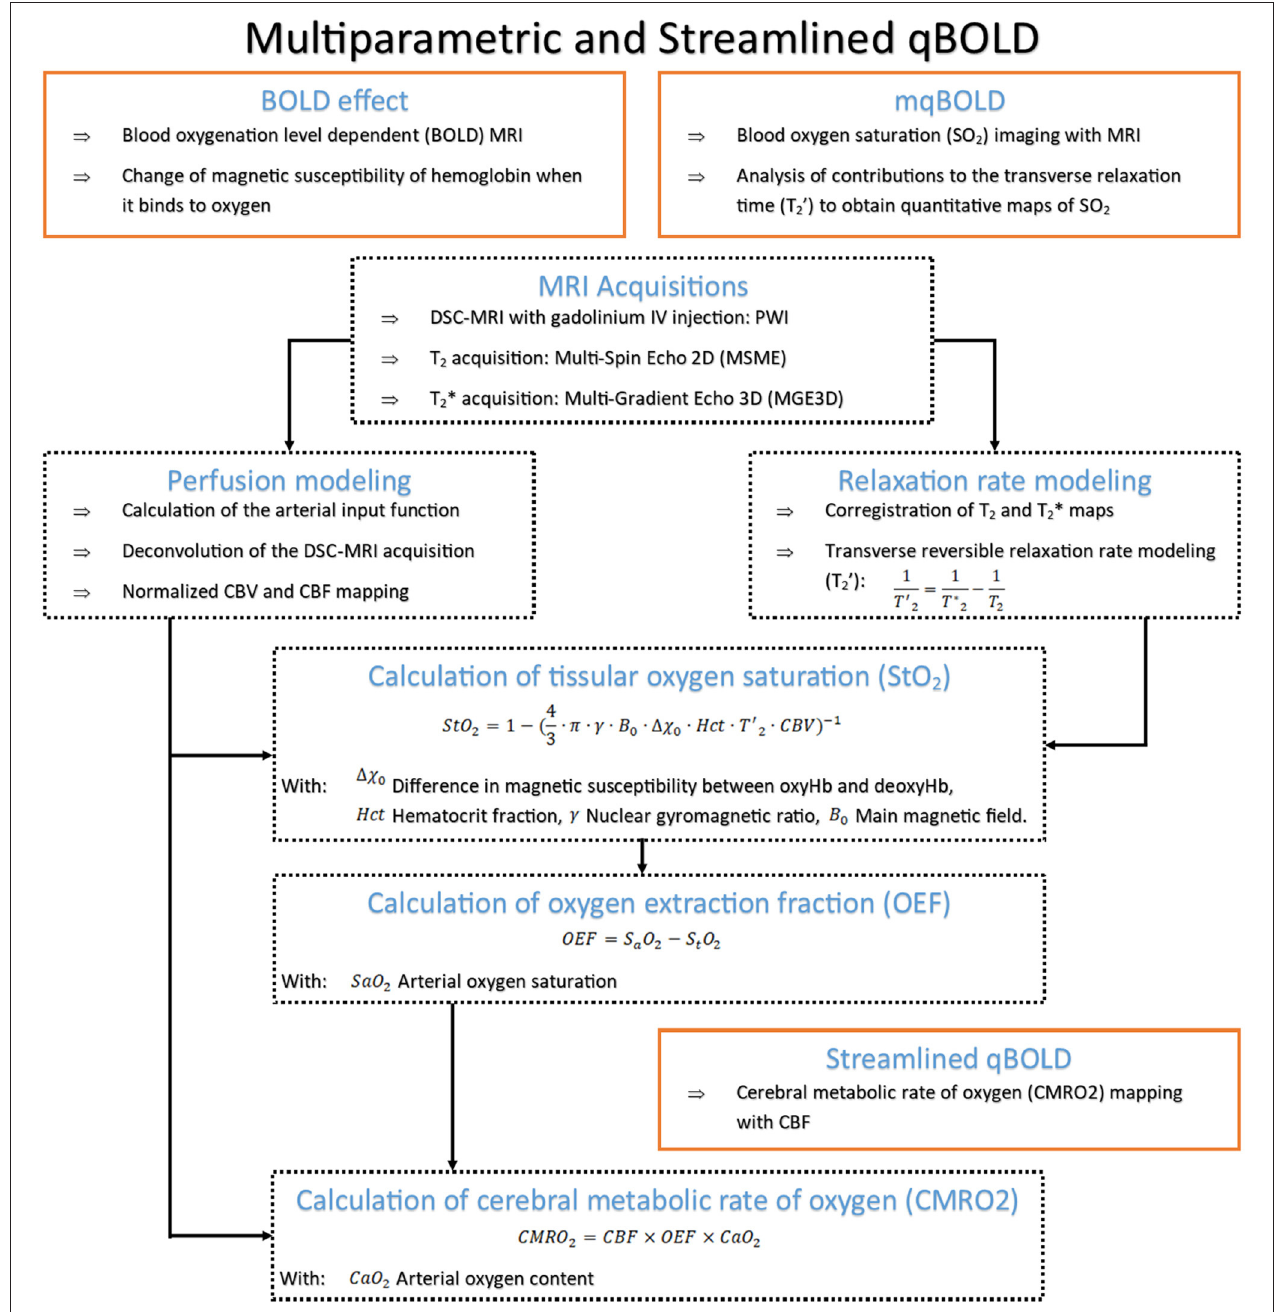
FIGURE 7 | Detailed principle and pipeline for OEF mapping with the multiparametric quantitative Blood Oxygen Level Dependent (mqBOLD) method and CMRO 2 mapping with streamlined qBOLD. MRI, magnetic resonance imaging; DSC, dynamic susceptibility contrast; IV, intravenous bolus; CBV, cerebral blood volume; CBF, cerebral blood